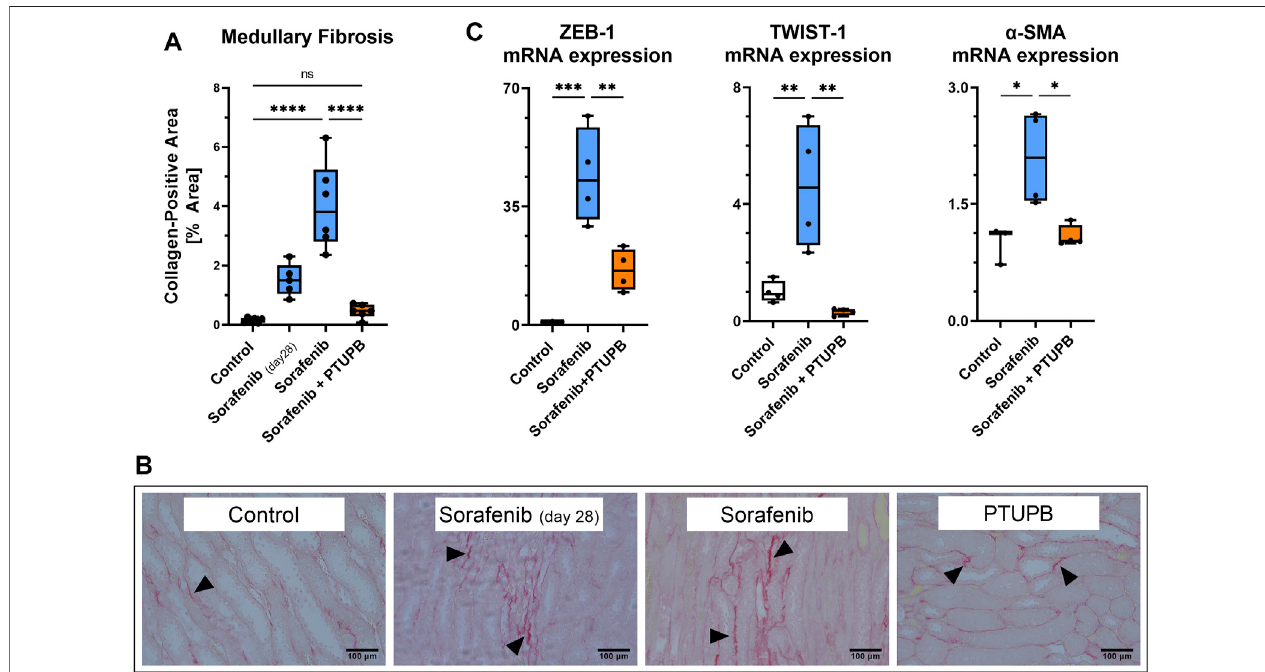
FIGURE 4 | Fibrosis. Fibrotic changes developed in the medulla of sorafenib-treated animals. PTUPB reversed fi brosis progression (A) . Representative images of fi brotic changes [picrosirius red (PSR) staining]. Arrowheads point to fi brotic areas. (B) Sorafenib treatment elevated ZEB-1 and TWIST-1 (EMT markers) as well as α -SMA (myo fi broblast marker). PTUPB mitigated the increase in those markers (C) . n (cid:1) 4 – 6 rats/group. Dots represent the average of duplicate measures for each individual rat. ns p > 0.05, * p ≤ 0.05, ** p ≤ 0.01, *** p ≤ 0.001, **** p ≤ 0.0001 determined byANOVA followed bythe Tukey post-hoc test. Dataare reported asbox and whisker plots with median, minimum to maximum, and 10 to 90